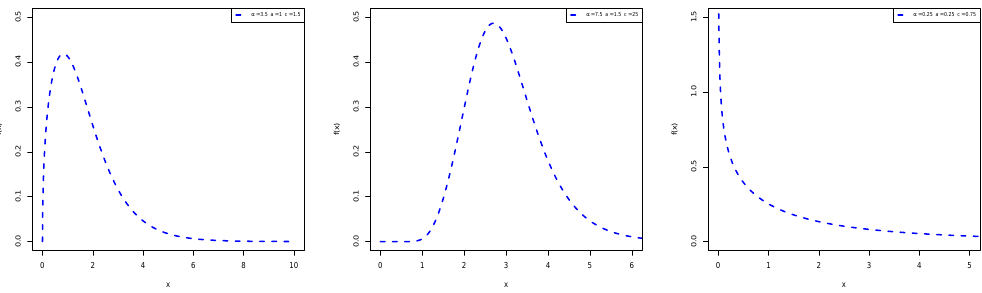
Figure 1. Plots of APExE PDFs for different parametric values.